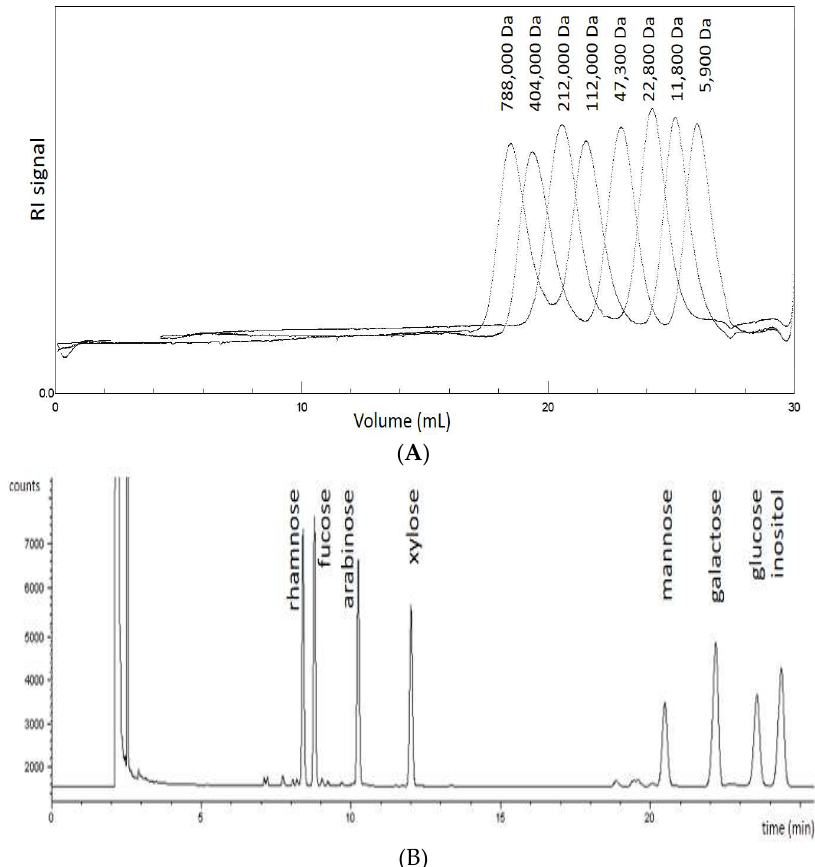
Figure 1. Size-exclusion chromatography (SEC) chromatograms of ( A ): pullalan standards, and ( B ): neutral sugars standards.